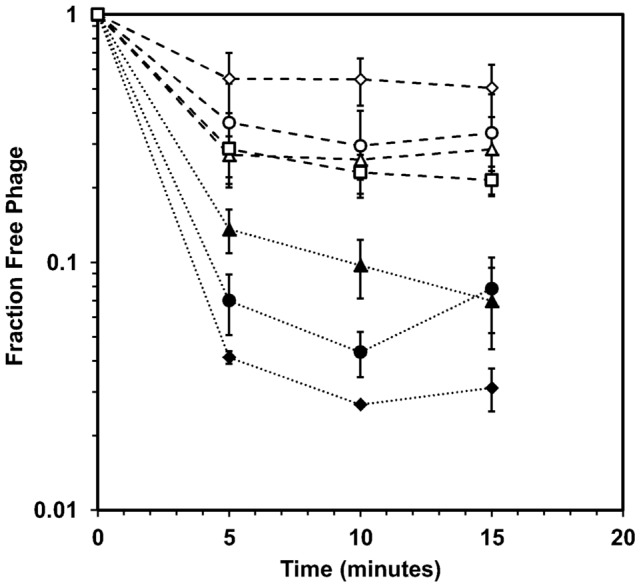
Adsorption of populations originating from single plaques.Adsorption curves of of R-type and M-type phage stocks isolated from individual plaques of the R8 and M8 populations are compared: R8 (open diamonds), R8P1 (open triangles), R8P2 (open circles), M8 (closed diamonds), M8P1 (closed triangles), M8P2 (closed circles), and the plaque isolated residuals of M8P1 (open squares). Error bars represent the standard deviation of three replicates for R8 and M8. For the plaque-isolated cultures, error bars present the standard deviation of at least three individual plaque-isolated cultures.